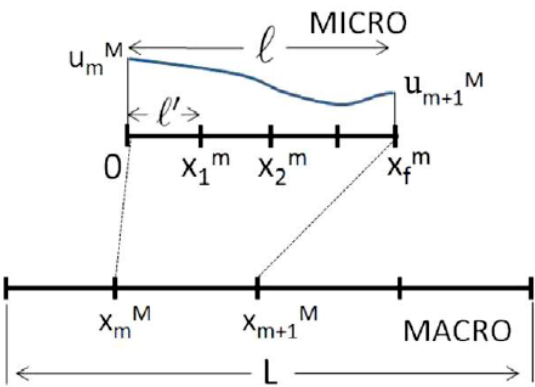
Figure 24. Microscopic and macroscopic discretization in the 1D problem within the proper generalized decomposition. The macro element sizes from 𝑋 (cid:3040)(cid:3014) to 𝑋 (cid:3040)(cid:2878)(cid:2869)(cid:3014) and the micro element has its internal resolution with 𝑥 (cid:2868)(cid:3040) = 𝑥 (cid:3040)(cid:3014) and 𝑥 (cid:3033)(cid:3040) = 𝑥 (cid:3040)(cid:2878)(cid:2869)(cid:3014) . Figure taken with permission from [135].